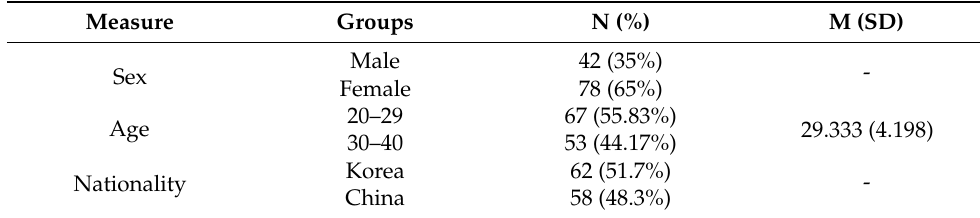
Table 3. Participants’ characteristics.